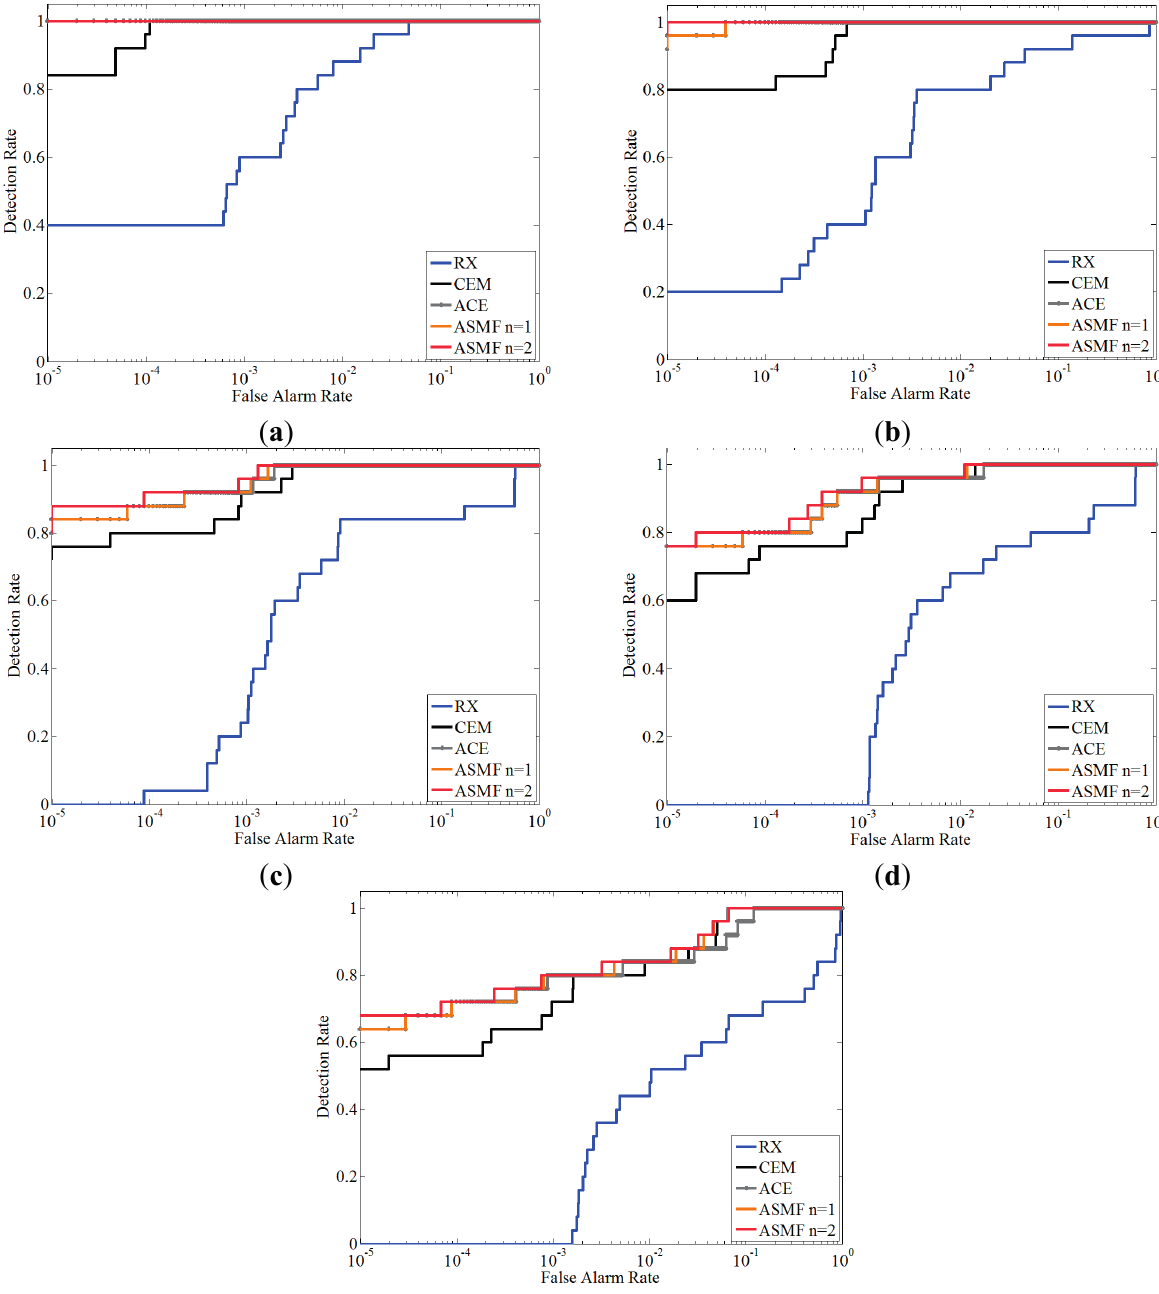
Figure 7. ROC curves of AVIRIS dataset, when the SNR value of white noise is ( a ) 30 dB, ( b ) 25 dB, ( c ) 20 dB, ( d ) 15 dB, and ( e ) 10